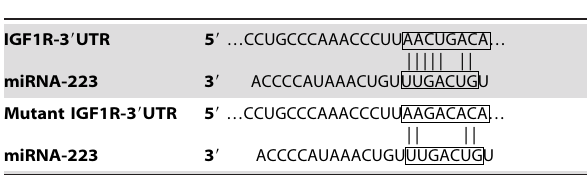
Table 1. Potential interactions between miRNA-223 and the 3 9 UTR of